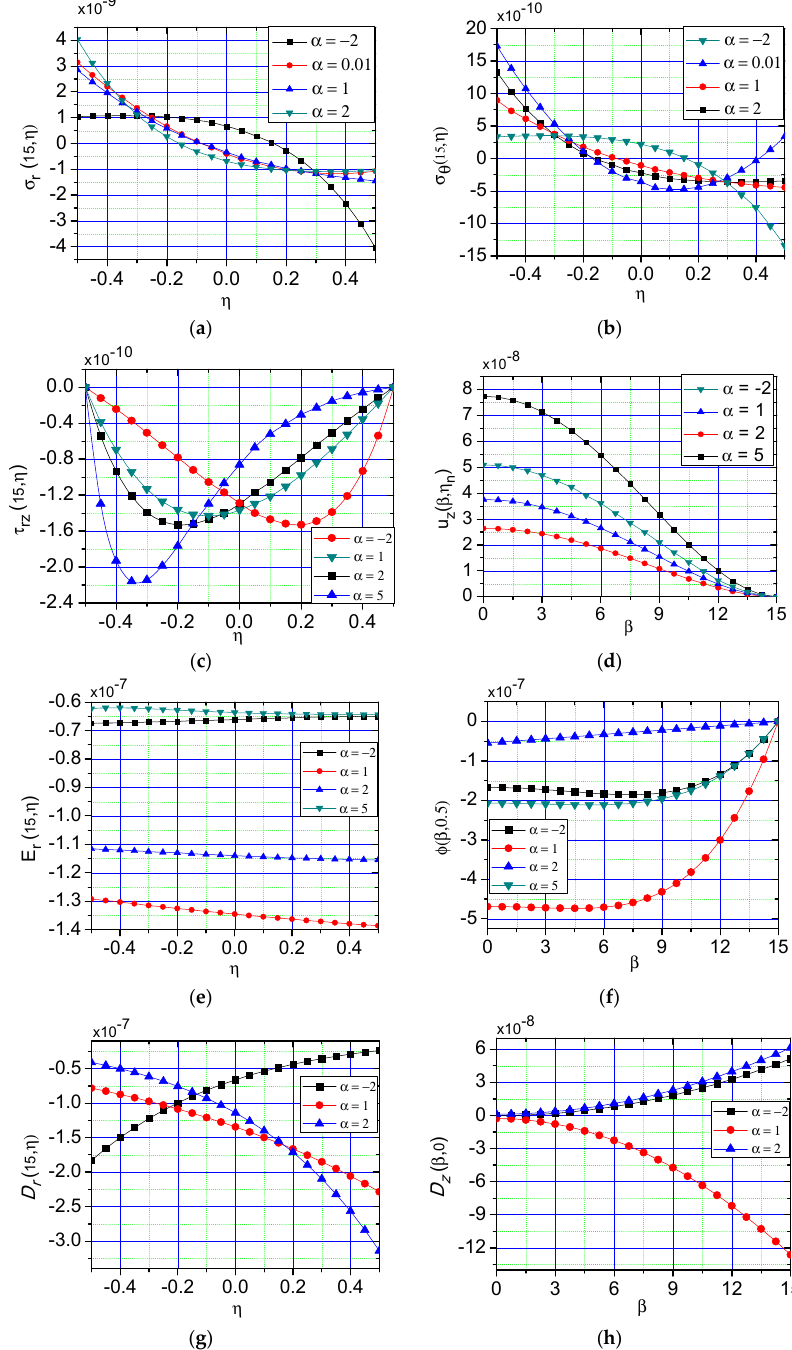
Figure 4. Variations under various gradient indices: ( a ) radial stress at plate edge, ( b ) circumferential stress at the plate’s edge, ( c ) shear stress at plate edge, ( d ) deflection at the neutral layer, ( e ) radial field intensity at the plate’s edge, ( f ) electrical potential at the lower surface, ( g ) radial electrical displacement at the plate’s edge, and ( h ) z -direction electrical displacement at middle